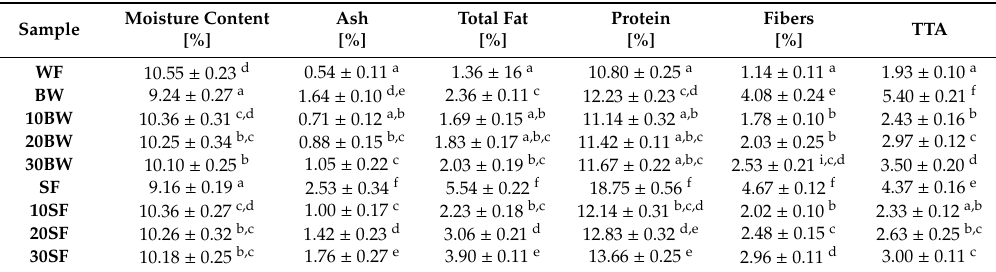
Table 3. Physico-chemical parameters of